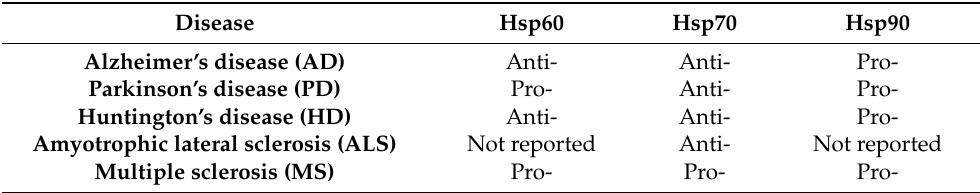
Table 1. Anti- and proinflammatory effects of extracellular Hsp60, Hsp70, and Hsp90 in neurodegen- erative